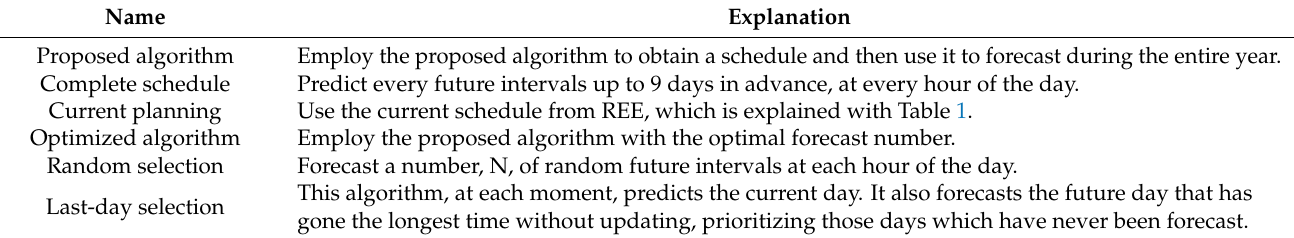
Table 2. Scheduling